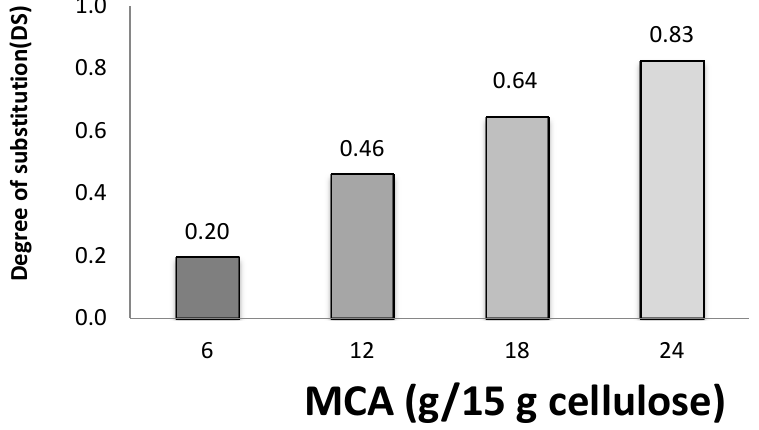
Figure 1. Effects of monochloroacetic acid (MCA) levels on degree of substation (DS) of Carboxymethyl Bacterial Cellulose from Nata de Coco (CMC n ).